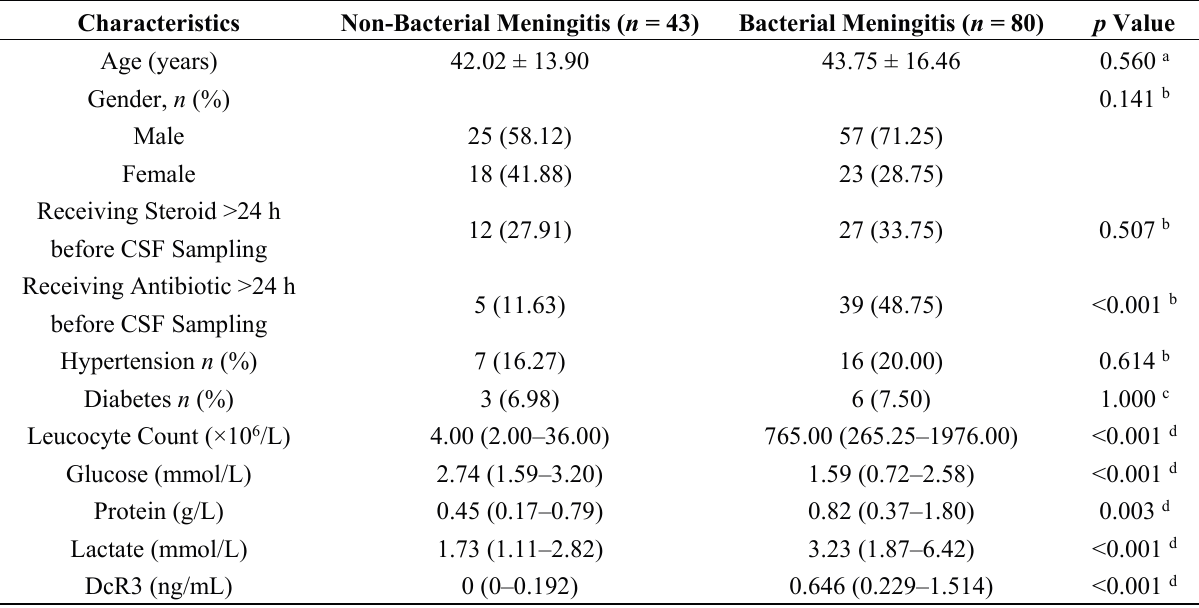
Table 1. Clinical features of the